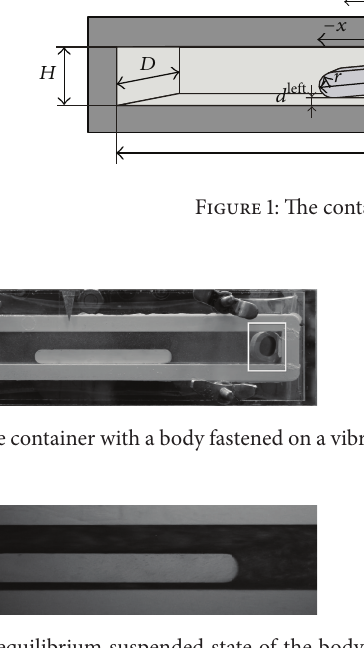
Figure 3: The quasi-equilibrium suspended state of the body in a vibrating cavity, 𝜌 = 6.5 , ] = 1.06 St, 𝑓 = 6.4 Hz, 𝑏 = 36.6 mm.